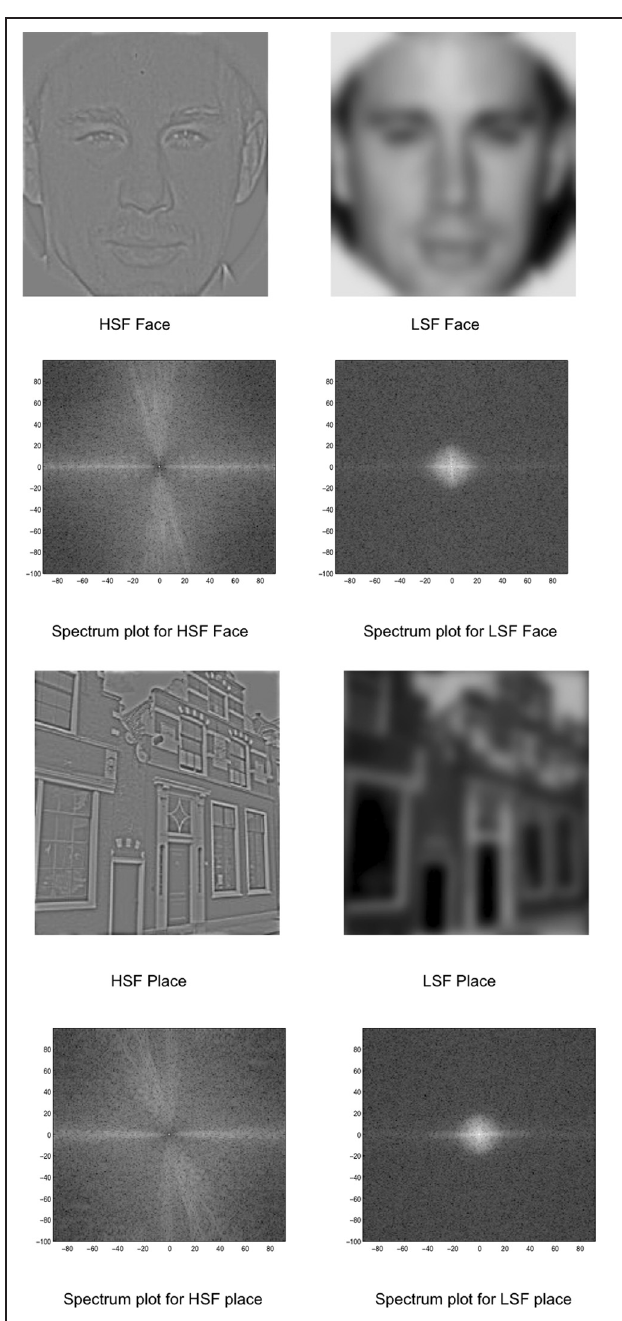
FIGURE 1 | Stimuli used in the experiment: HSF and LSF versions of faces and places. The spectrum is displayed as a polar plot, where contrast energy (log) is plotted as a function of spatial frequency (distance from the origin; low-to-high) and orientation (angle).